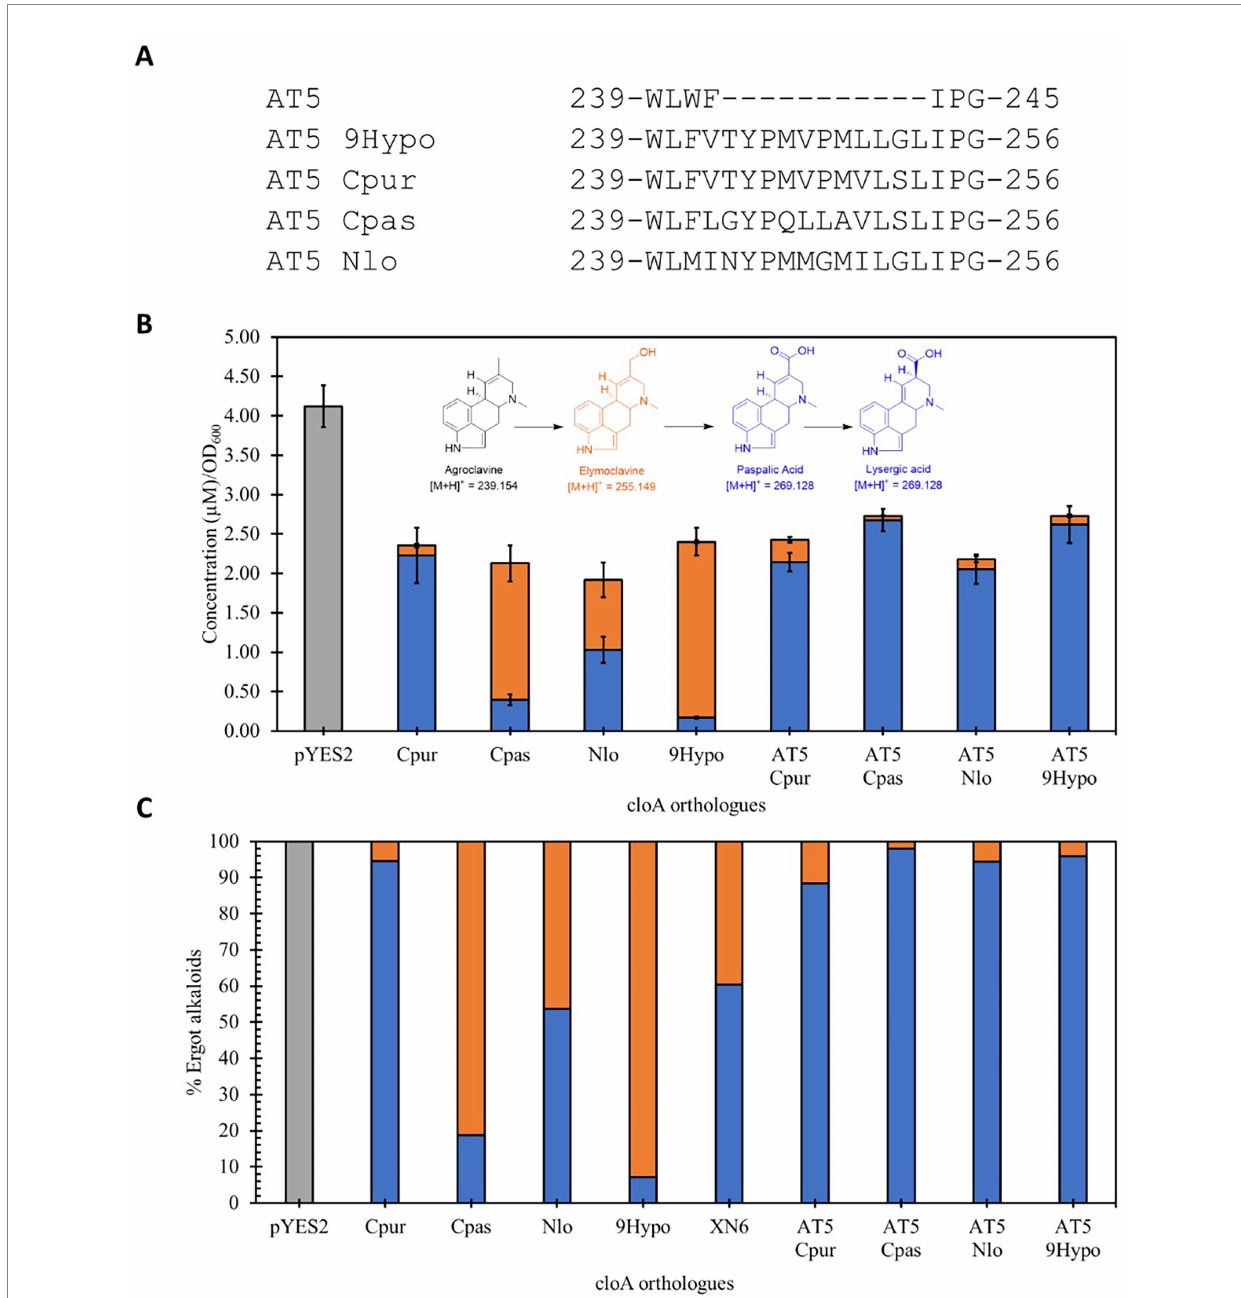
FIGURE 7 Screening of lysergic acid producing wildtype CloA and chimeric AT5 CloAs in the presence of agroclavine. (A) Sequence alignment of the inserted sequences from lysergic acid producing CloA into AT5 CloA. (B) Activity screening of chimeric AT5 CloAs. Blue bars represent the mean concentration of lysergic acid while orange bars represent the mean concentration of elymoclavine produced by CloA orthologs. Error bars are representative of three biological replicates. (C) Percentage of produced ergot alkaloids by lysergic acid producing wildtype CloA and chimeric AT5